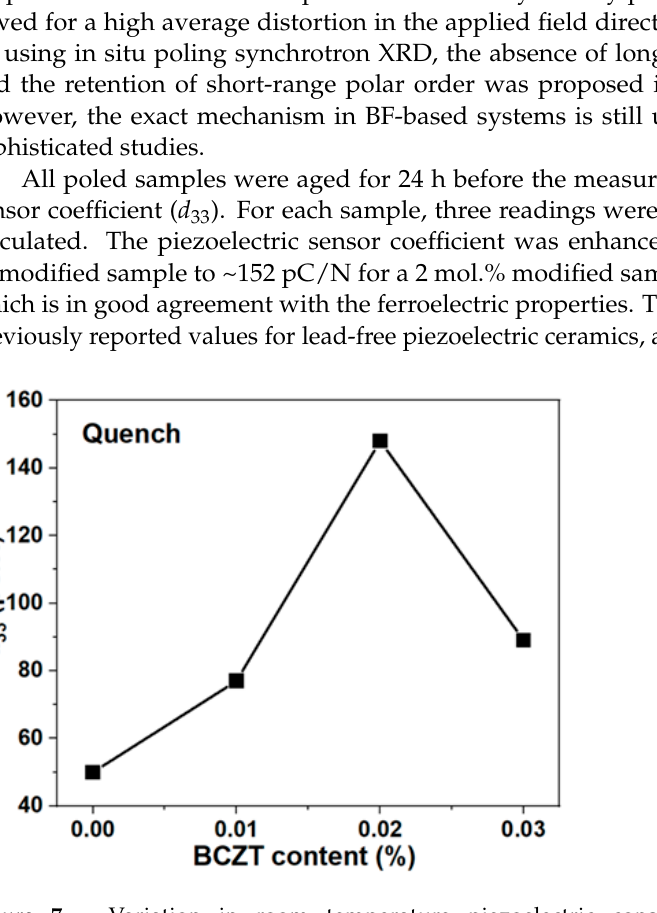
Figure 7. Variation in room temperature piezoelectric constant ( d 33 ) of BFBT–zBCZT (z = 0.00–0.030) ceramics.